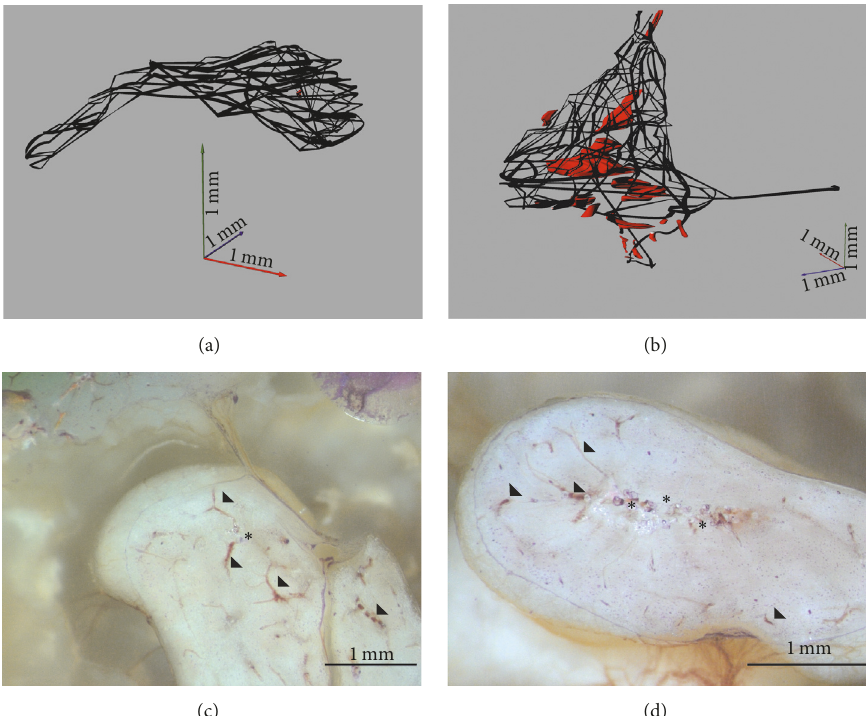
Figure 3: The blood vessel system inside the malleus (a, c) and incus (b, d) of the 3D model of the stained histological planes (a, b) compared with the selected planes (c, d). The blood vessel system (black) and the small cartilage areas (red) inside the malleus (a) and incus (b) are reconstructed three-dimensionally. Exemplary reflected light microscopic images of the grinding surface after surface staining with the modified staining according to Mann-Dominici demonstrate the blood vessels (arrowhead) and cartilage (asterisk) inside the malleus head (c) and incus body (d). Grinding surfaces after removing (c) 7.893 mm and (d) 6.565 mm of the total sample,